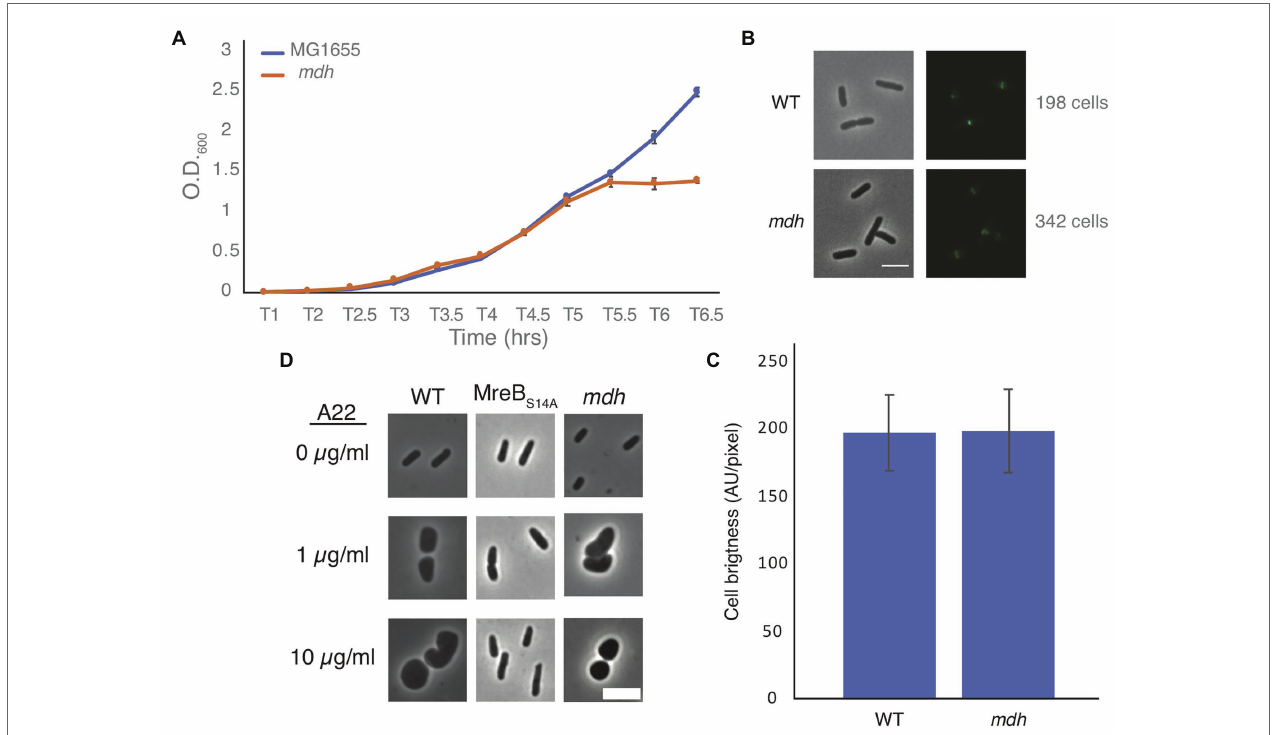
FIGURE 2 | Malate dehydrogenase deletion cells grow at the same rate as WT cells but lose shape under A22 treatment. (A) Representative growth curve of WT and mdh deletion cells grown in triplicate. Cells were grown overnight in LB and set to the same O.D. before a 1:1,000 dilution was made into fresh LB. Error bars are SD. (B) Phase-contrast and GFP images of WT or mdh cells with a functional fluorescent FtsZ-GFP fusion. (C) Quantification of cell brightness from cells expressing FtsZ-GFP in exponential phase. (D) Phase-contrast images of cells grown with different A22 concentrations. Cells were grown for 4 h in LB or A22 1 μ g/ ml. Cells were grown for 2 h in LB before 10 μ g/ml, A22 was added for an additional 2 h. Scale bars are 4 μ